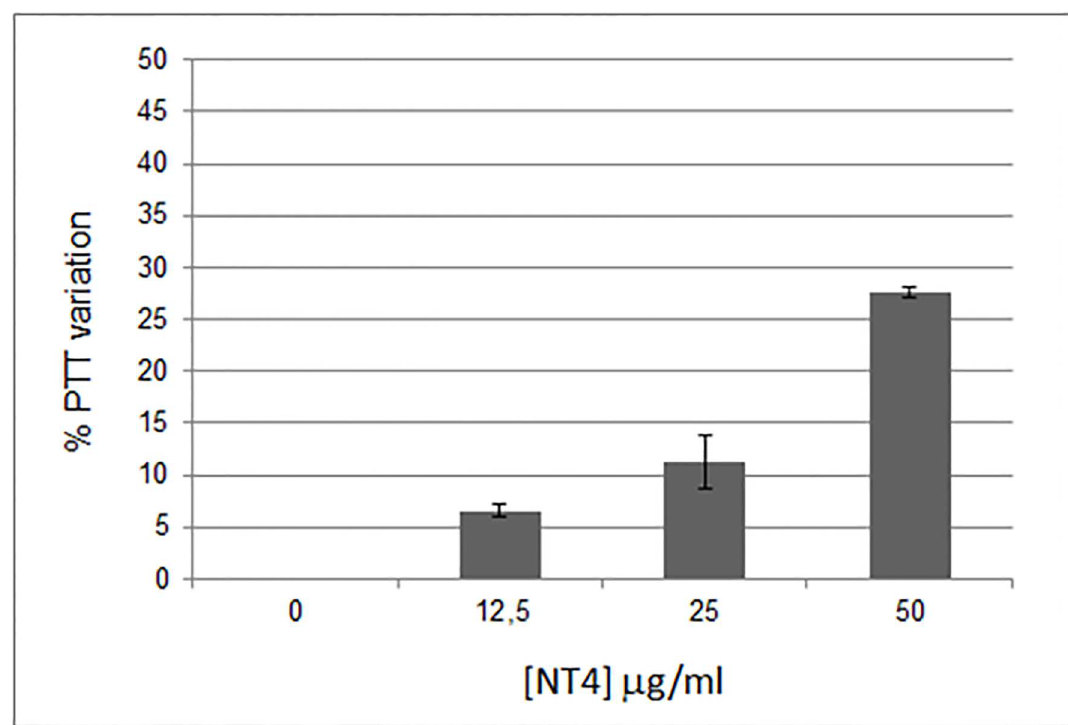
Fig 5. Dose-dependent anticoagulant effect of